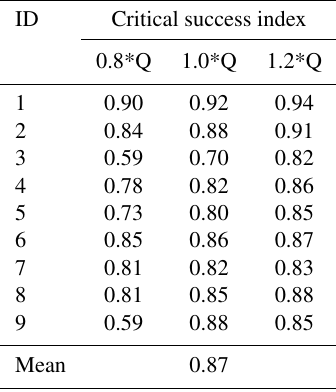
Table 2. Results of the benchmarking of nine events against HWM- derived flood